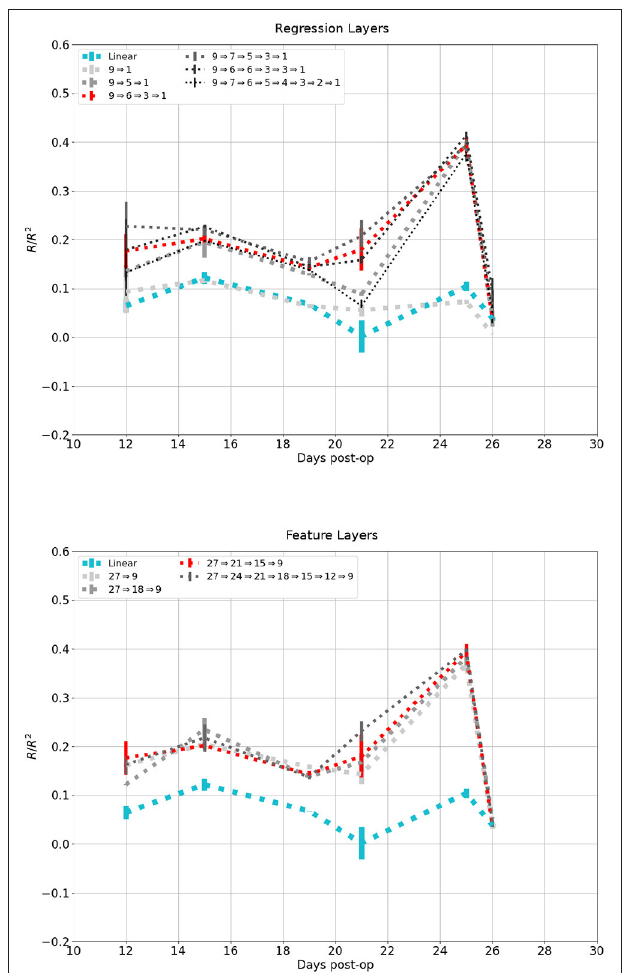
FIGURE 10 | Reconstruction of the same signal in Figure 6B using increasing number of network layers. Darker and thinner lines corresponds to deeper networks. Red and Cyan line correspond to the network and linear control shown in previous figures. Top : Fixed feature layers, Bottom : Fixed Regression